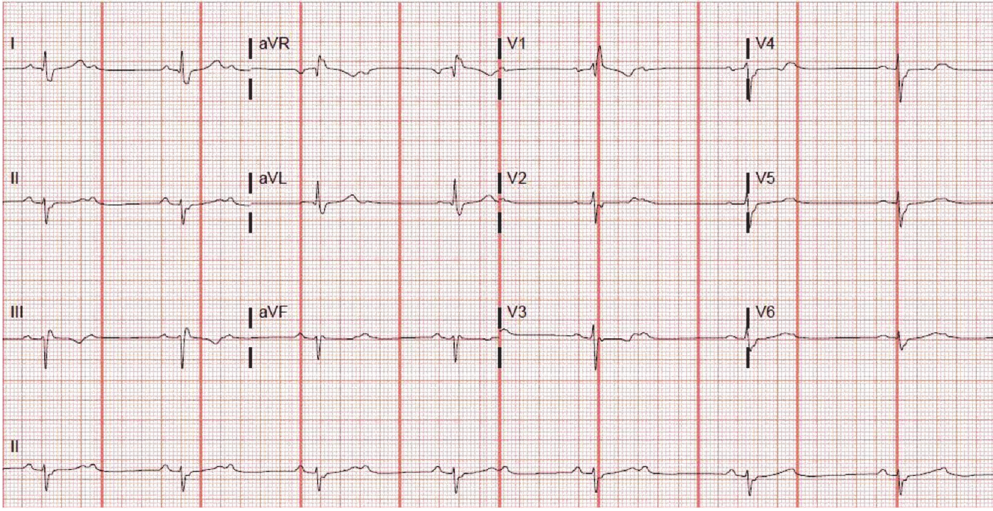
Figure 2: EKG showing second-degree type II heart